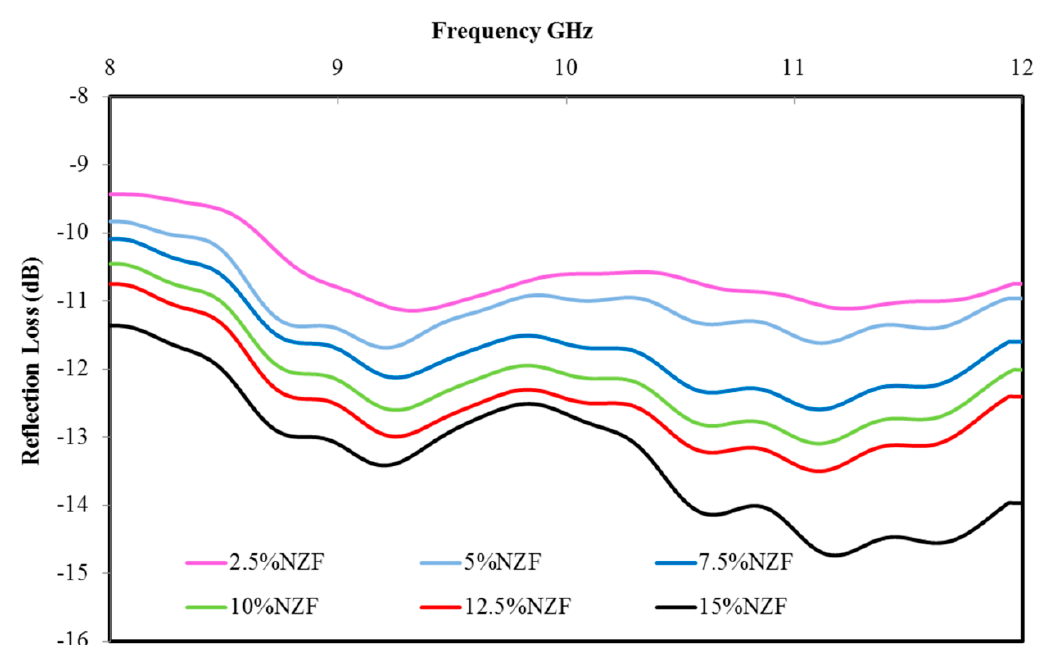
Figure 9. Variation in absorption of NZF + OPEFB + PCL composites.